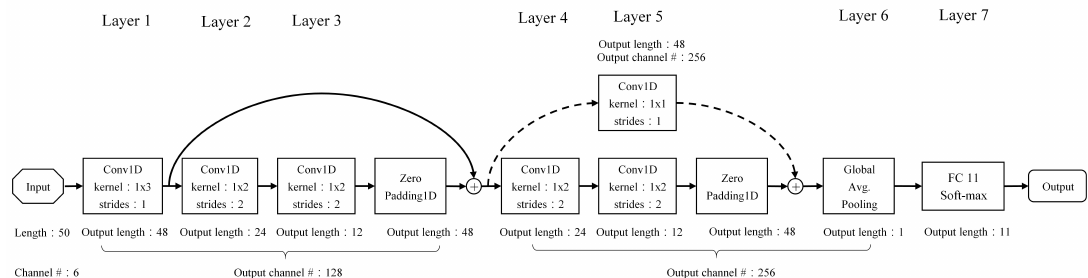
Figure 6. The parameters of the Residual PairNet. The input X t has the same dimension and number of channels as those of the input of PairNet. The network contains seven layers and two short-cut connections. Two zero-padding modules are also included for the combination of the short-cut connections with the convolutional layers. Layers 1–5 are convolution layers. Layer 6 is the average pooling layer. The number of gestures to be classified is Q = 11. Layer 7 is a fully connected layer producing 11